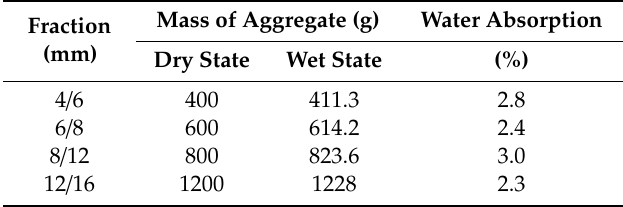
Table 3. Water absorption of recycled concrete aggregate